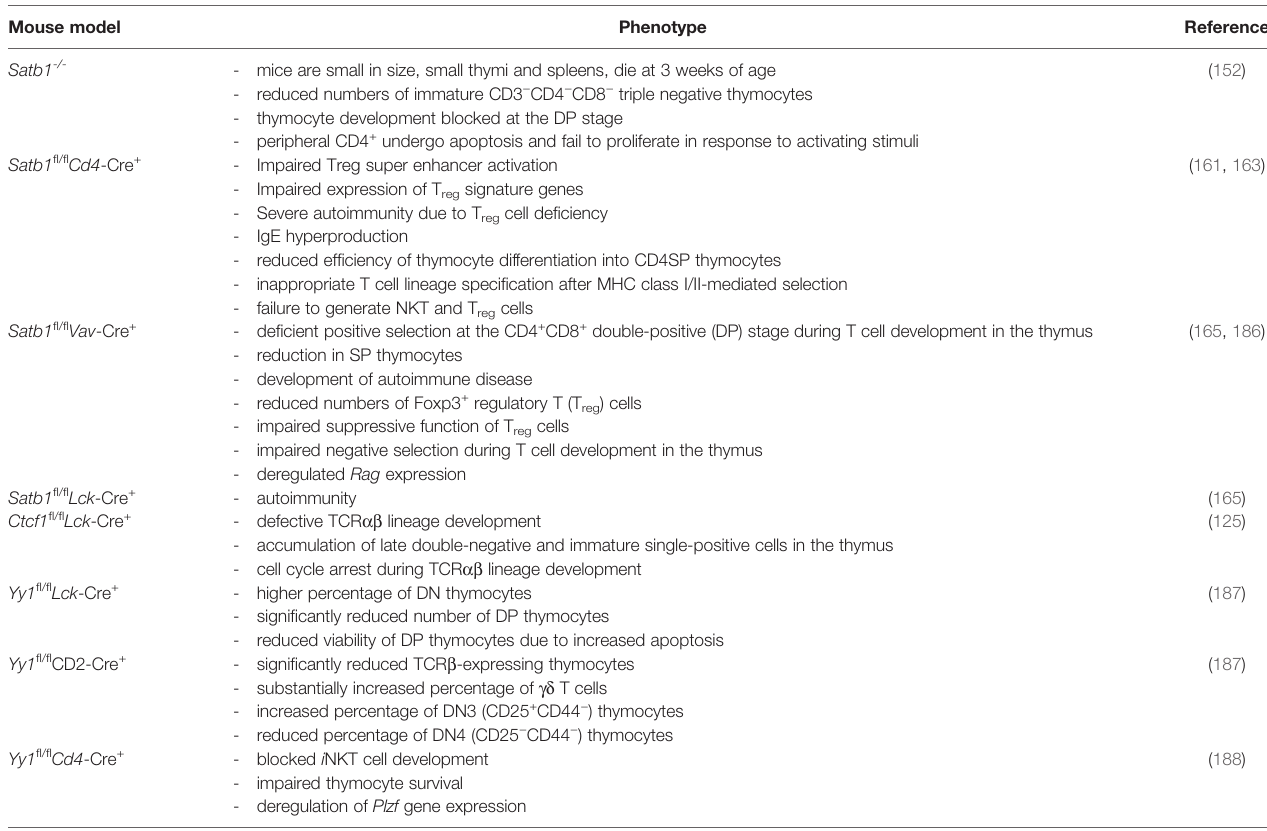
TABLE 1 | Mouse models of genome organizers and their respective phenotype affecting T cell physiology. Mouse